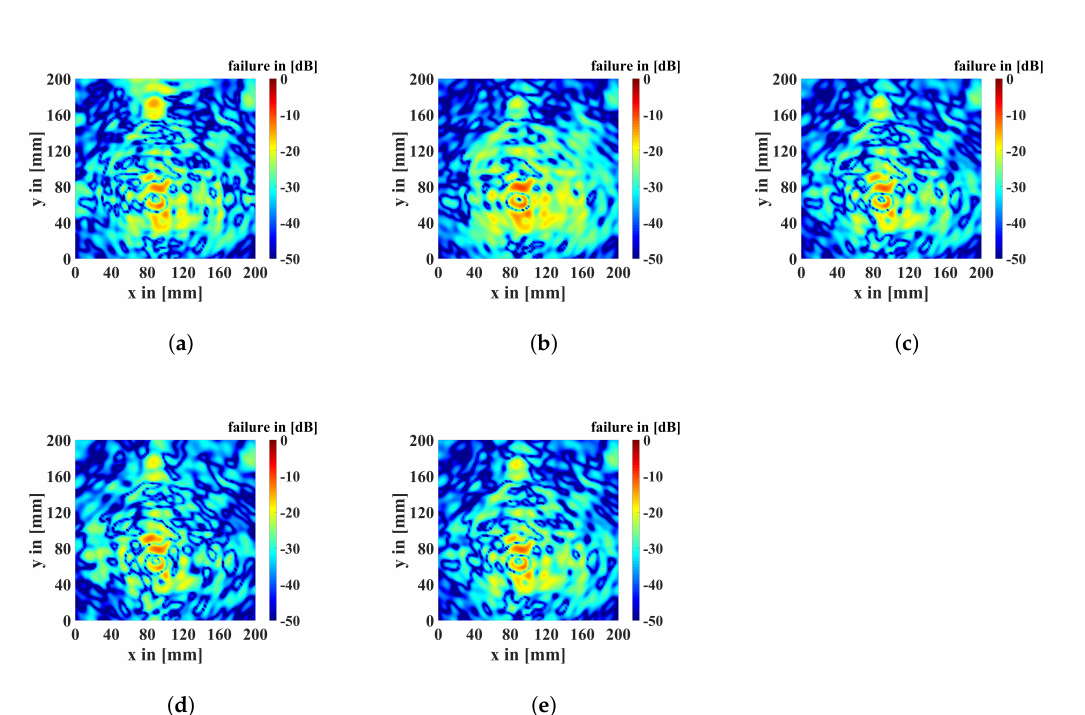
Figure 12. Error images of the different interpolation methods for the refining of the measurement values related to the “default” image. Interpolation method ( a ) “nearest”; ( b ) “linear”; ( c ) “cubic”; ( d ) “spline” and ( e )